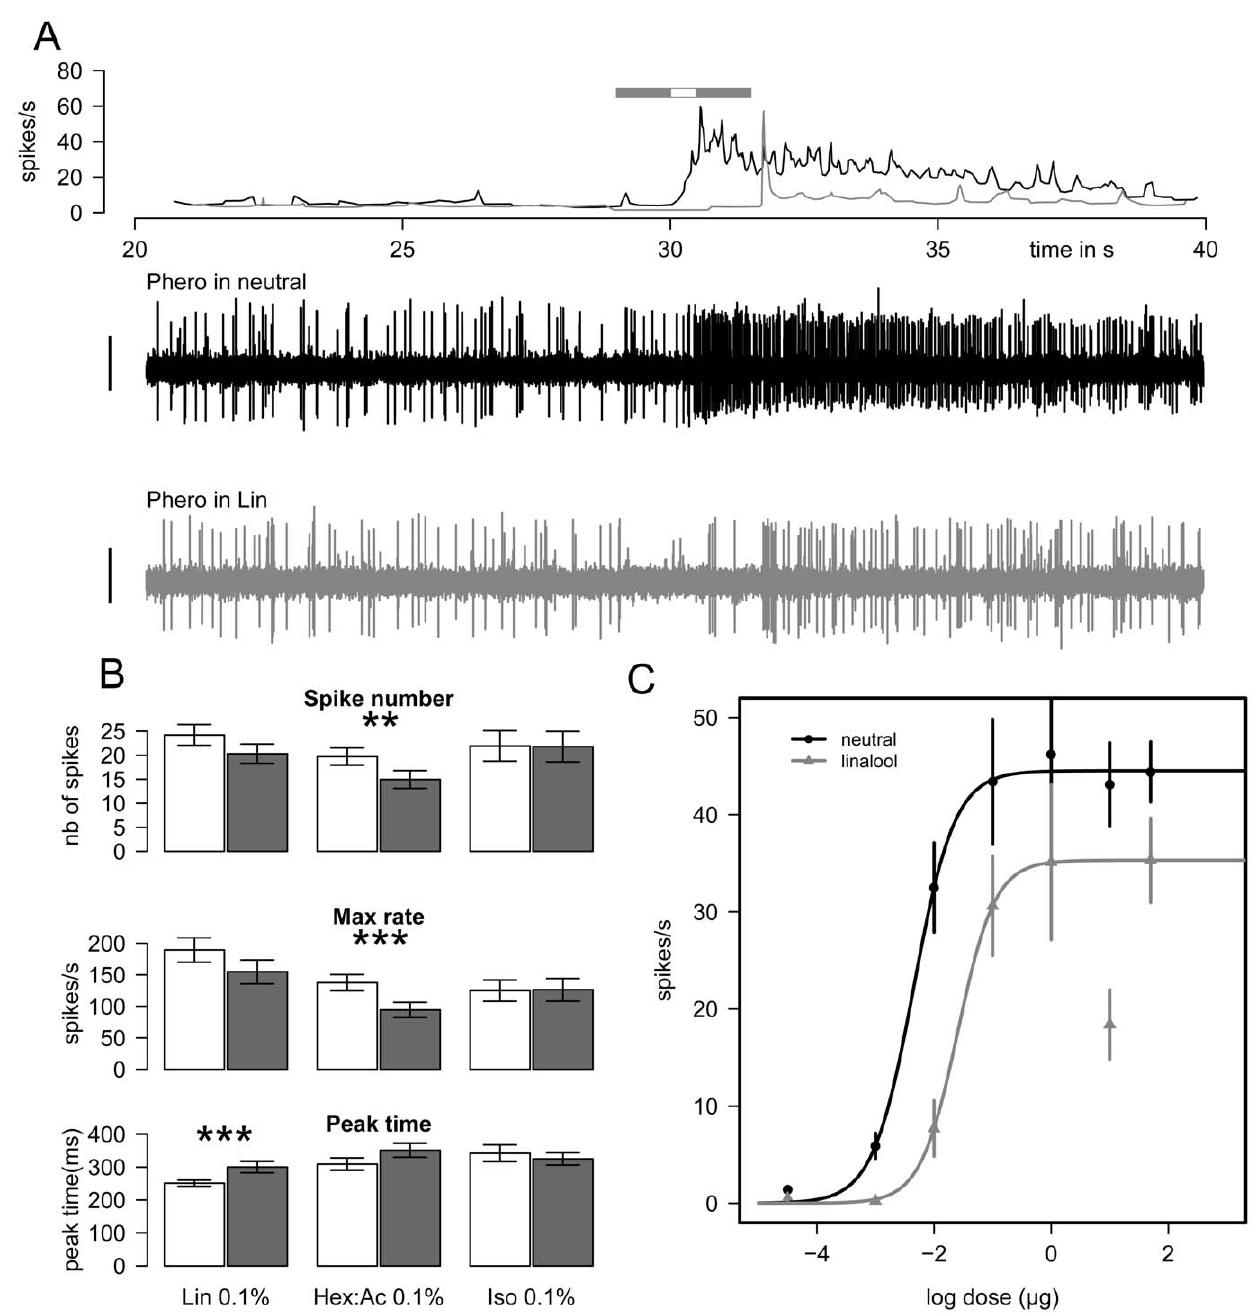
Figure 1. Lin and Hex:Ac backgrounds modify Ph-ORNs responses. A) Two examples of extracellular recordings from a Ph-ORN that showed a response to 1 m g Phero in neutral (middle trace, black) or Lin backgrounds (lower trace, grey) with corresponding frequency plots (upper graph; times of odor presentations are symbolized by a grey horizontal bar for the Lin background, and a white bar for Phero stimulus). Vertical bar=1 mV. B) Responses of Ph-ORNs to Phero in the presence of neutral (white bars) or in PV backgrounds (grey bars, Lin, Hex:Ac or Iso at 0.1%). Bar plots present the number of spikes emitted during the pheromone stimulation (upper), the maximum firing rate (middle) and the peak time of the response (lower). Responses of Ph-ORNs in the different PV backgrounds were recorded from different insects (mean 6 SEM, N=20 2 22). Asterisks indicate significant differences at 1% for ** and 0.1% for ***, Wilcoxon signed-rank test for paired values. C) Dose-response curve to Phero in neutral (black curve) or Lin (grey curve) backgrounds (mean 6 SEM, N=13 2 30). doi:10.1371/journal.pone.0052897.g001 were different according to the PV. As shown by examples of more rapidly reached: the response to 10 m g was the same as with individual tracks, PWR were affected by the addition of Lin and 1 m g. Hex:Ac but not of Iso (Figure 4). Globally, males decreased their Experiment 2: ‘‘addition of PV’’. The effects of the addition of a PV background while males were engaged in PWR speed just after the Lin or Hex:Ac onset, walked in a loop for ten